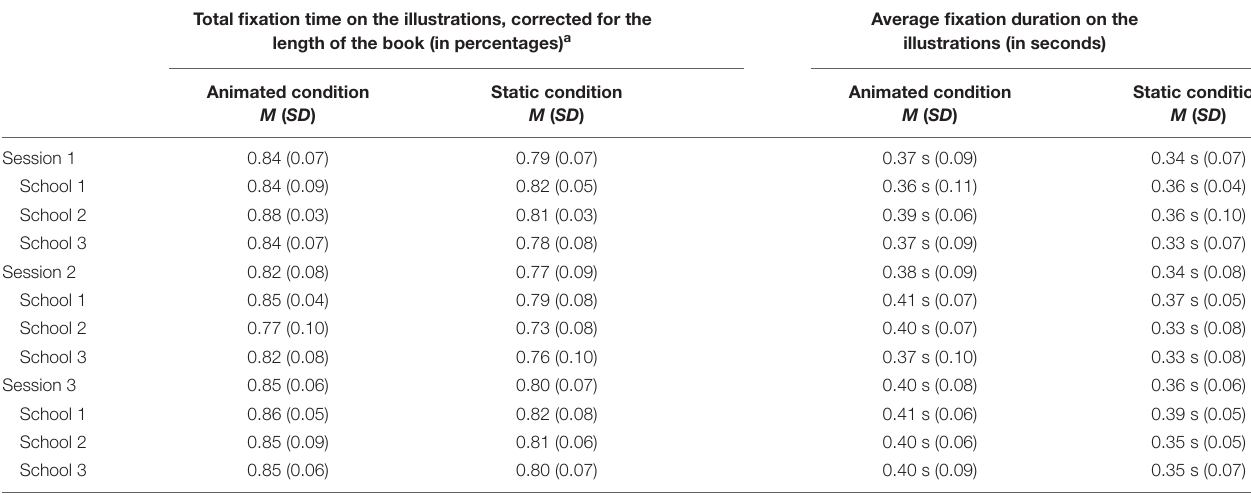
TABLE 3 | Visual attention to the illustrations in animated and static books during the first, second, and third session. Total fixation time on the illustrations, corrected for the length of the book (in percentages) a